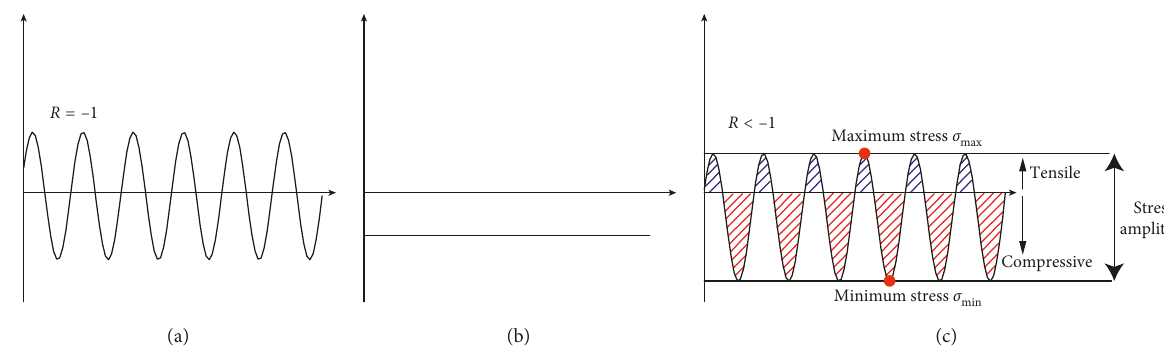
Figure 11: Stress distribution after superimposing applied stress and residual compressive stress ( R is the stress ratio, R � σ (a) Applied stress. (b) Residual stress. (c) Superimposed stress.